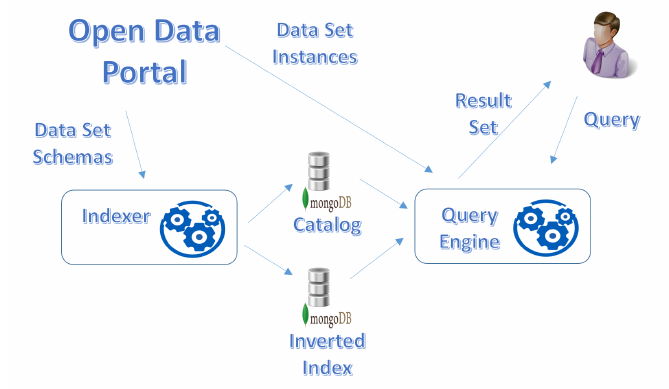
Figure 2. Original retrieval approach implemented within the former Hammer